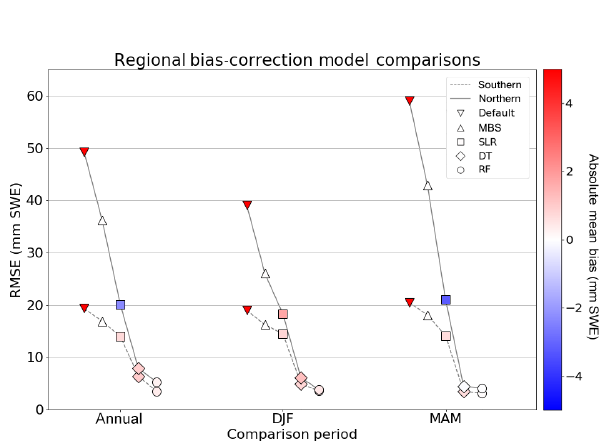
Figure 2. Performance results of regional bias-correction methods – mean bias subtraction (MBS), simple linear regression (SLR), de- cision tree regression (DT) and random forest regression (RF) – for northern and southern geographic regions across DJF, MAM and the combined annual snow season